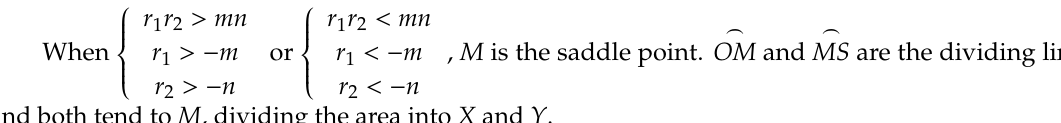
and both tend to M , dividing the area into X and Y .